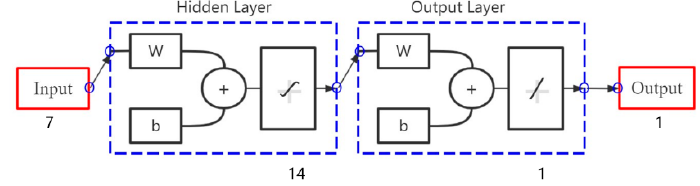
Figure 3. The model structure of BP neural network.